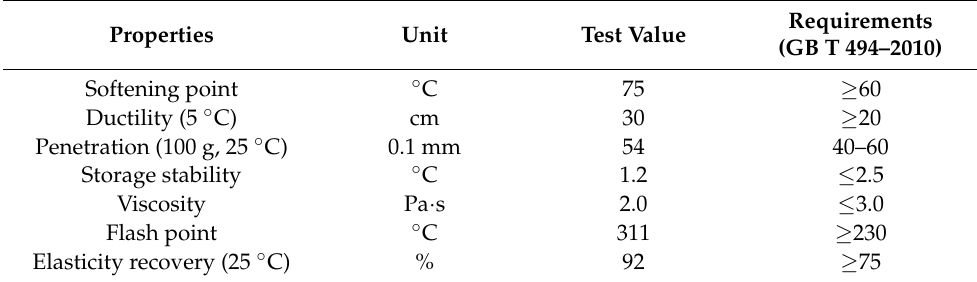
Table 1. Main technical indicators of SBS modified asphalt.